Question: Write a single sentence explaining what this figure depicts.
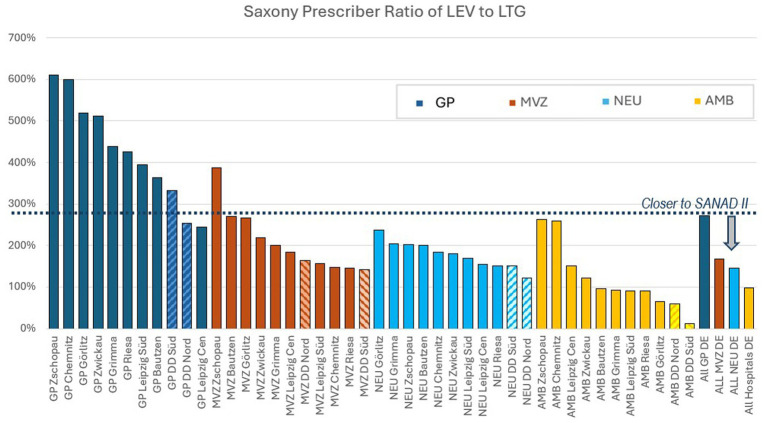
Answer: Regional Distribution of the LEV to LTG Prescribing Ratio Across Provider Groups in Saxony Relative to SANAD II Benchmarks: General Practitioners (GP), Outpatient Neurologists (NEU), Medical Care Centers (MVZ), and Specialized Hospital Outpatient Clinics (AMB). Horizontal reference line indicates the national GP benchmark (~300%). Data points illustrate the inverse relationship between medical specialization level and the LEV: LTG ratio, highlighting the shift toward LTG-dominant Closer to SANAD II prescribing in specialized DGfE centers (e.g., DD) compared to rural GP sectors. Striped columns highlight providers located within the Dresden metropolitan area, illustrating a geographic proximity effect where local prescribing patterns align more closely with the specialized DGfE center.